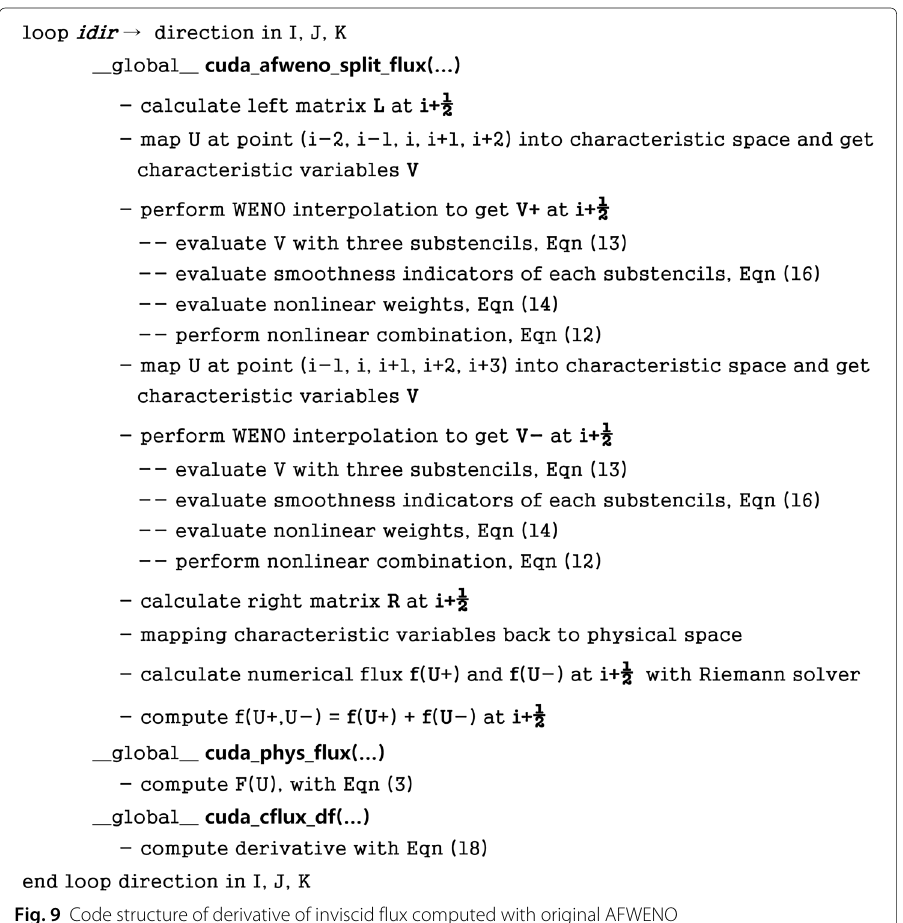
Fig. 9 Code structure of derivative of inviscid flux computed with original AFWENO